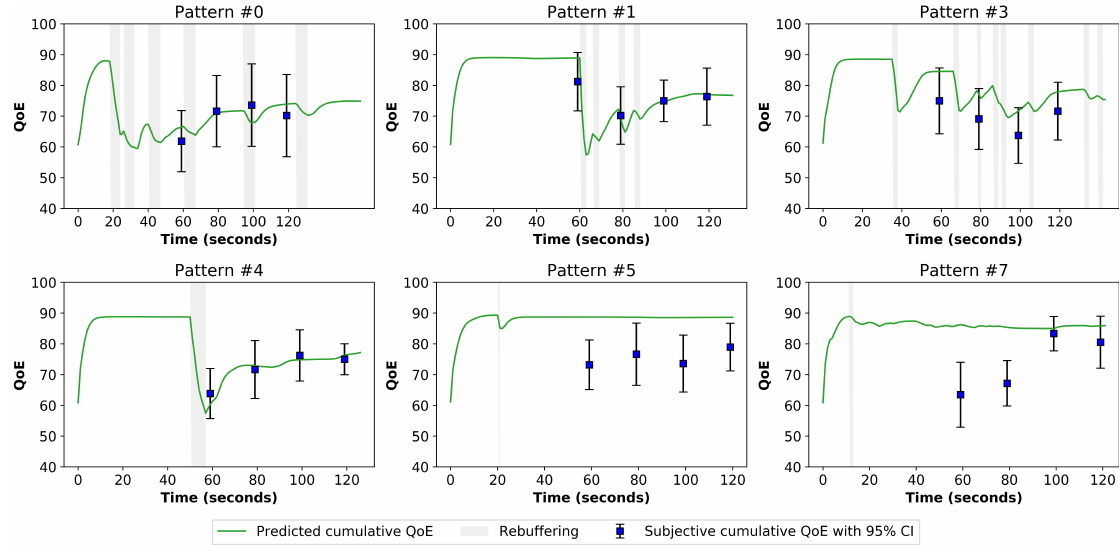
Figure 11. Performance of our predicted cumulative QoE in comparison with the subjective cumulative